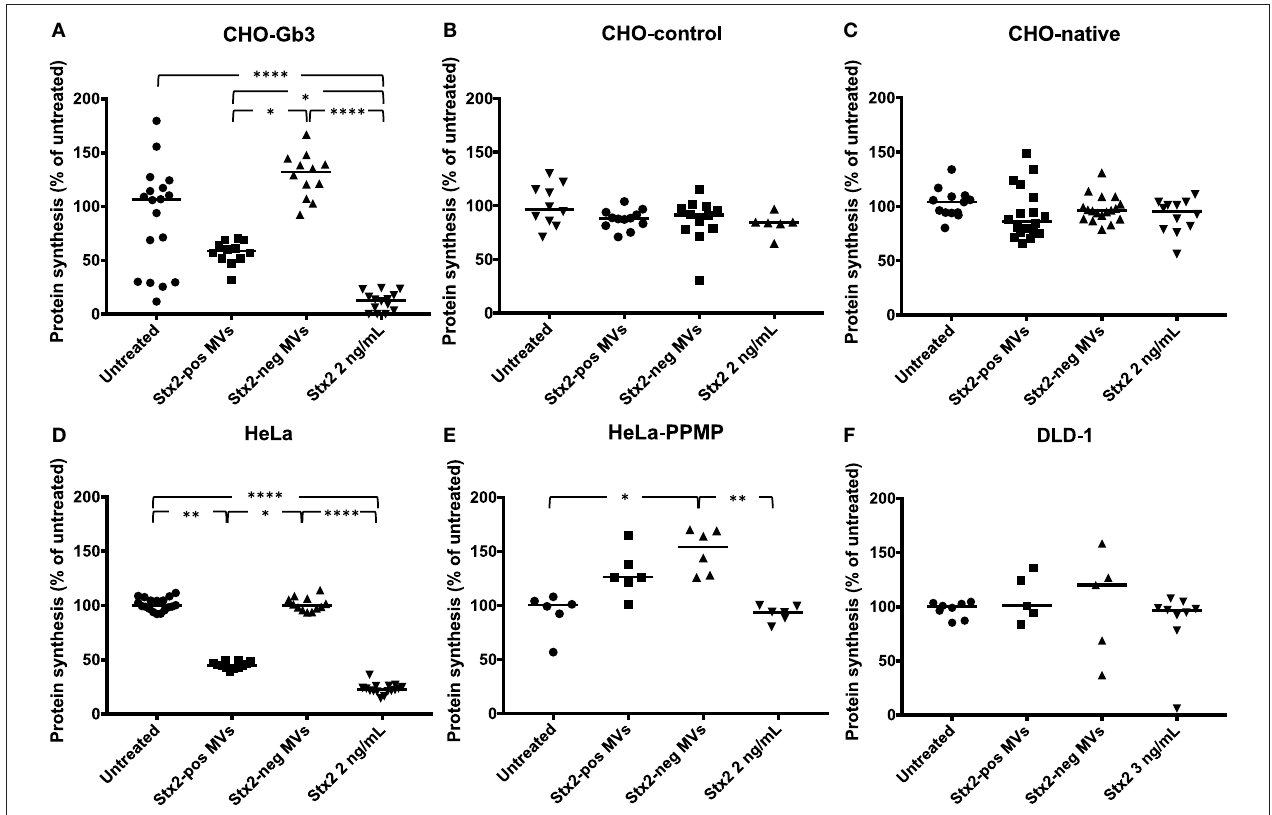
FIGURE 2 | Stx2-positive microvesicles are toxic to Gb3-positive but not Gb3-negative cells. CHO-Gb3, CHO-control and CHO native cells, HeLa and HeLa-PPMP and DLD-1 cells were incubated with Shiga toxin 2 positive microvesicles (Stx2-pos MVs), Stx2-negative microvesicles (Stx2-neg MVs), Stx2 or PBS and protein synthesis was measured. (A) CHO-Gb3 cells were incubated with Stx2-positive microvesicles ( n = 12), Stx2-negative microvesicles ( n = 12), free Stx2 ( n = 14), or PBS ( n = 18). A significant decrease in protein synthesis was seen in both Stx2-positive microvesicles and free Stx2 compared to Stx2-negative microvesicles (2 independent experiments). (B) CHO-control cells were treated with Stx2-positive microvesicles ( n = 12), Stx2-negative microvesicles ( n = 12), free Stx2 ( n = 6), or PBS ( n = 10). No differences in protein synthesis were noted between the groups (one experiment). (C) CHO native cells were incubated with Stx2-positive microvesicles ( n = 18), Stx2-negative microvesicles ( n = 18), free Stx2 ( n = 12), or PBS ( n = 13). No differences in protein synthesis were noted between the groups (three independent experiments). (D) HeLa cells were incubated with Stx2-positive microvesicles ( n = 12), Stx2-negative microvesicles ( n = 12), free Stx2 ( n = 16), or PBS ( n = 18). Cells treated with Stx2-positive microvesicles and free Stx2 exhibited significantly lower protein synthesis compared to untreated and Stx2-negative microvesicle-treated cells (two independent experiments). (E) HeLa-PPMP cells were treated with Stx2-positive microvesicles ( n = 6), Stx2-negative microvesicles ( n = 6), free Stx2 ( n = 6), or PBS ( n = 6). No difference in protein synthesis was seen between the groups (one experiment). (F) DLD-1 cells were incubated with Stx2-positive microvesicles ( n = 5), Stx2-negative microvesicles ( n = 5), free Stx2 ( n = 9), or PBS ( n = 8). No differences in protein synthesis were seen between